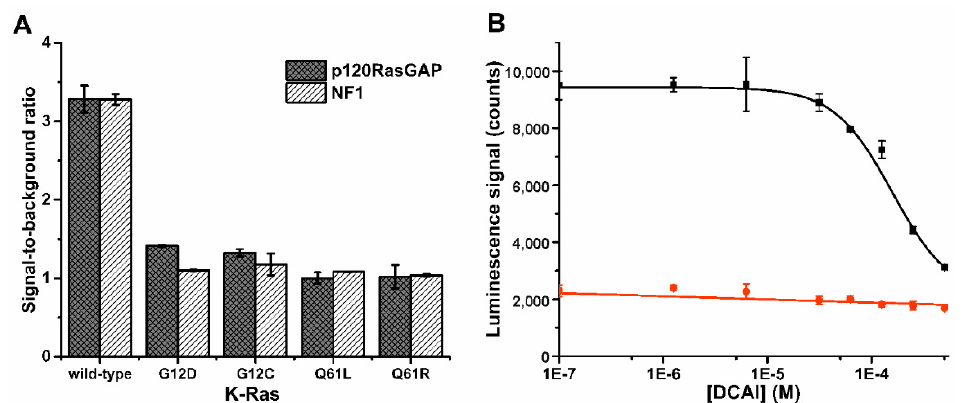
Figure 3. Time-gated Tb(III)-luminescence monitoring of the K-Ras GTPase activities. ( A ) GTPase cycle of GDP-GTP exchange (SOS cat ) and GTP hydrolysis (p120RasGAP or NF1) with wild-type K-Ras reduces GTP concentration increasing Probe 1 time-gated Tb(III)-luminescence. This GTP hydrolysis in impaired with mutant K-Ras proteins, which gave low Tb(III)-luminescence. ( B ) DCAI inhibits SOS cat dependent GDP-GTP exchange and thus impairs GTP hydrolysis resulting Tb(III)-luminescence quenching with wild-type K-Ras (black), while no change in Q61R K-Ras mutant (red) signal were detected. Data represent mean ± SD (n = 3).